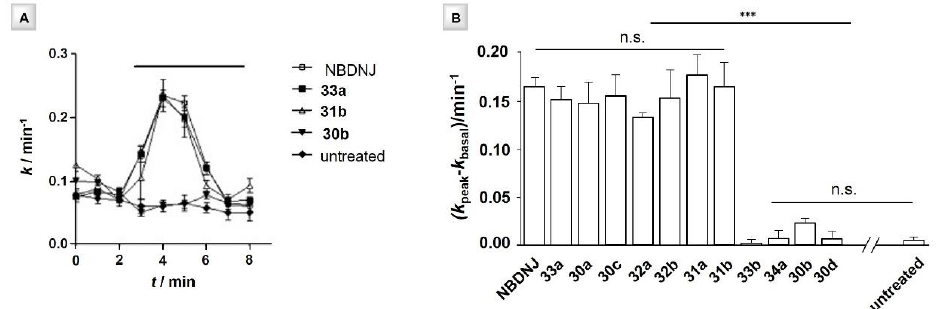
Figure 9. ( A ) Rescue of functional F508del-CFTR activity: iodide efflux curves on untreated or iminosugar-treated CF-KM4 cells in the presence of forskolin/genistein. ( B ) Summary of the functional evaluation of F508del-CFTR: histograms represent the mean (± SEM) of four experiments obtained by the iodide efflux technique in cystic fibrosis (CF) cells untreated or treated (100 μM, 2 h) in the presence of forskolin/genistein. *** p < 0.001; n.s., not significant. This figure is adapted with permission from [106]).